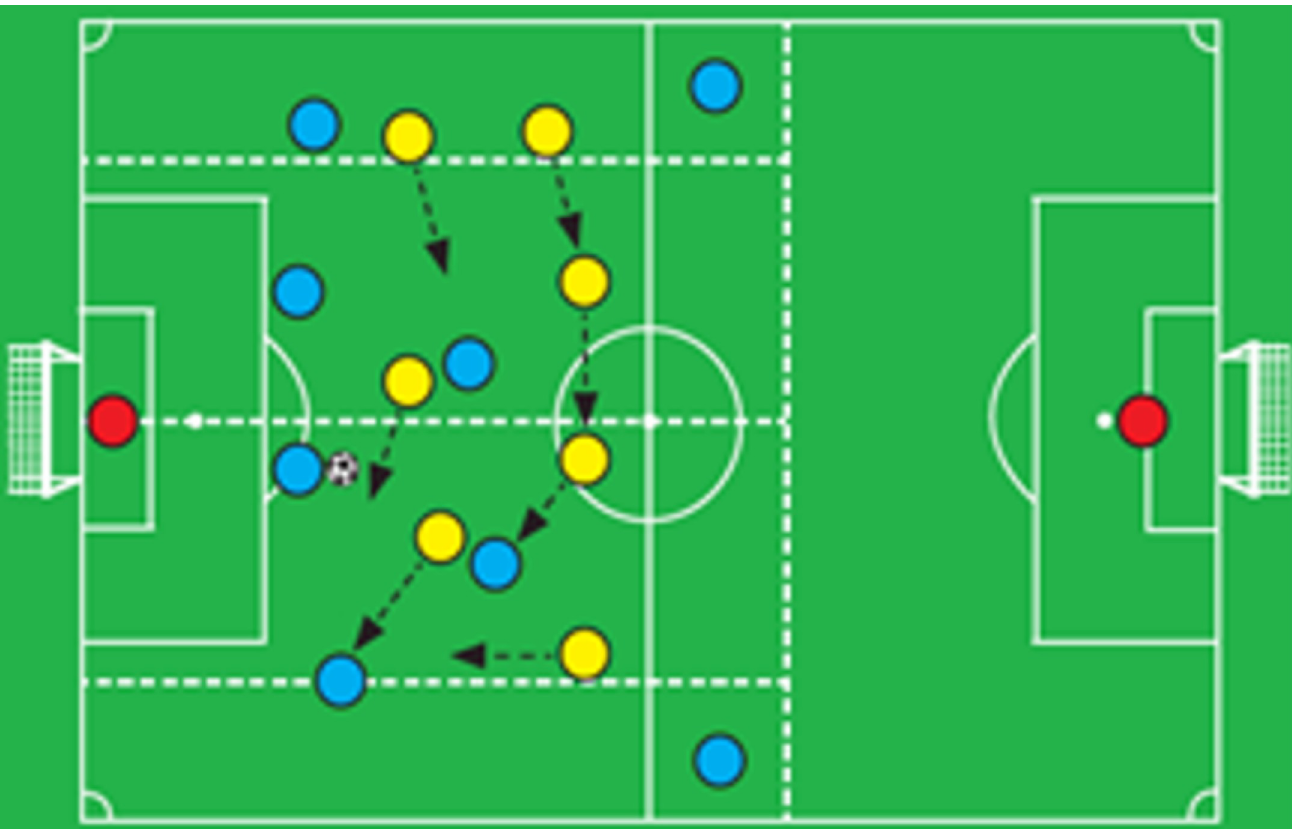
Fig 11. Variation of the set play drill in the FIFA coach manual [53] recreated in unity for our simulation. The user with the ball and his/her teammates are in blue, goalkeepers in red, rivals are in yellow. Arrows indicate the trajectories of the rivals during the scene.